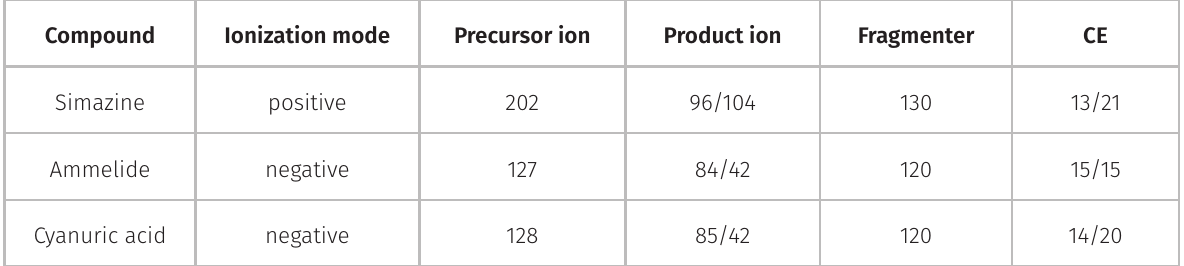
Table I. The parameters of MS/MS